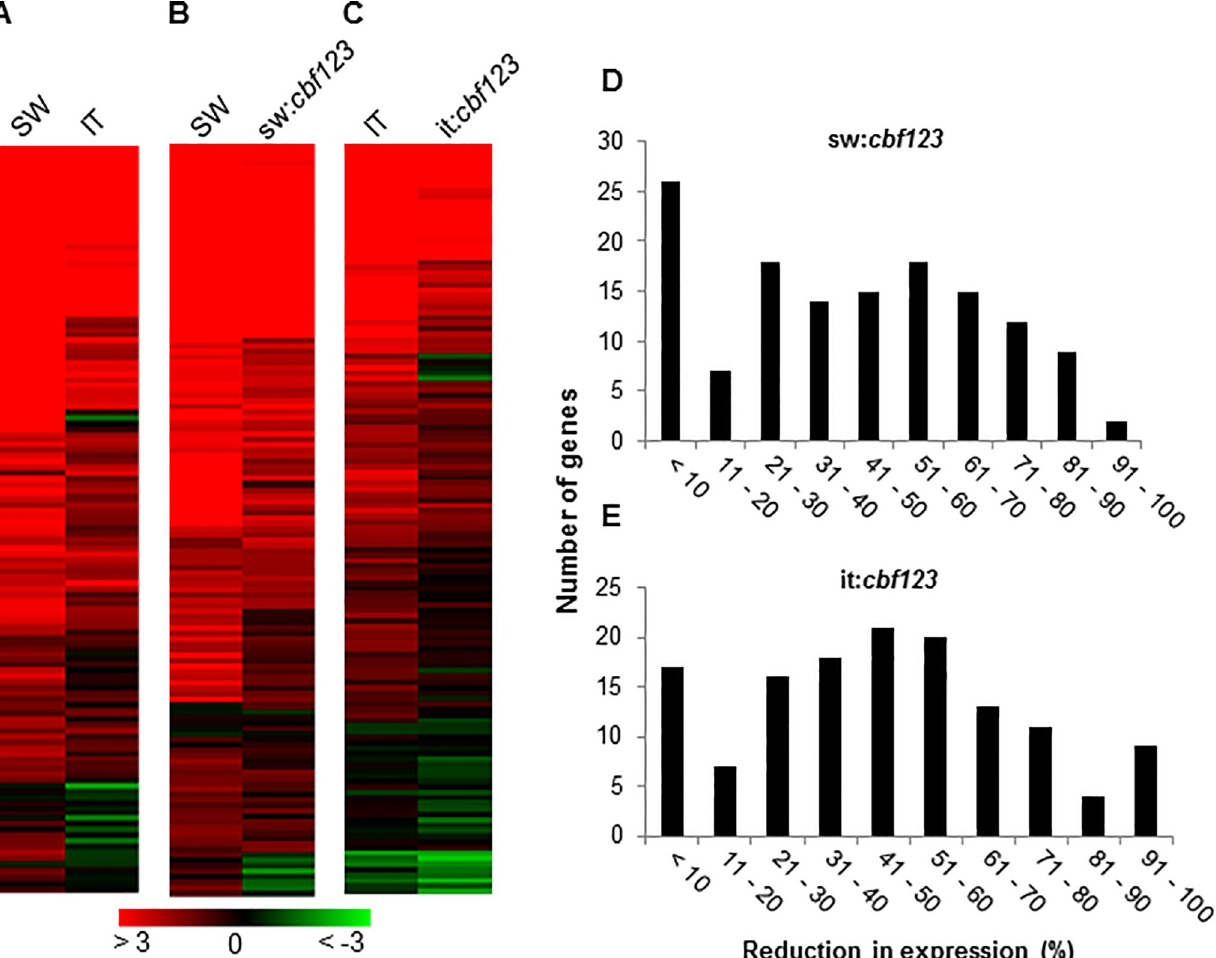
Fig 3. Inactivation of the CBF pathway in the SW and IT ecotypes impairs rapid cold induction of CBF regulon genes. (A, B, C) Transcript levels for the 136 CBF regulon genes of Arabidopsis Ws-2 [14] were compared between (A) IT and SW, (B) SW and sw: cbf123 , and (C) IT and it: cbf123 plants after exposure to 4˚C for 24 h. Heat maps represent log 2 fold-change. (D, E) Histograms showing the number of CBF regulon genes that were reduced in expression at low temperature (4˚C for 24 h) in the cbf123 triple mutants compared with their respective WT plants.